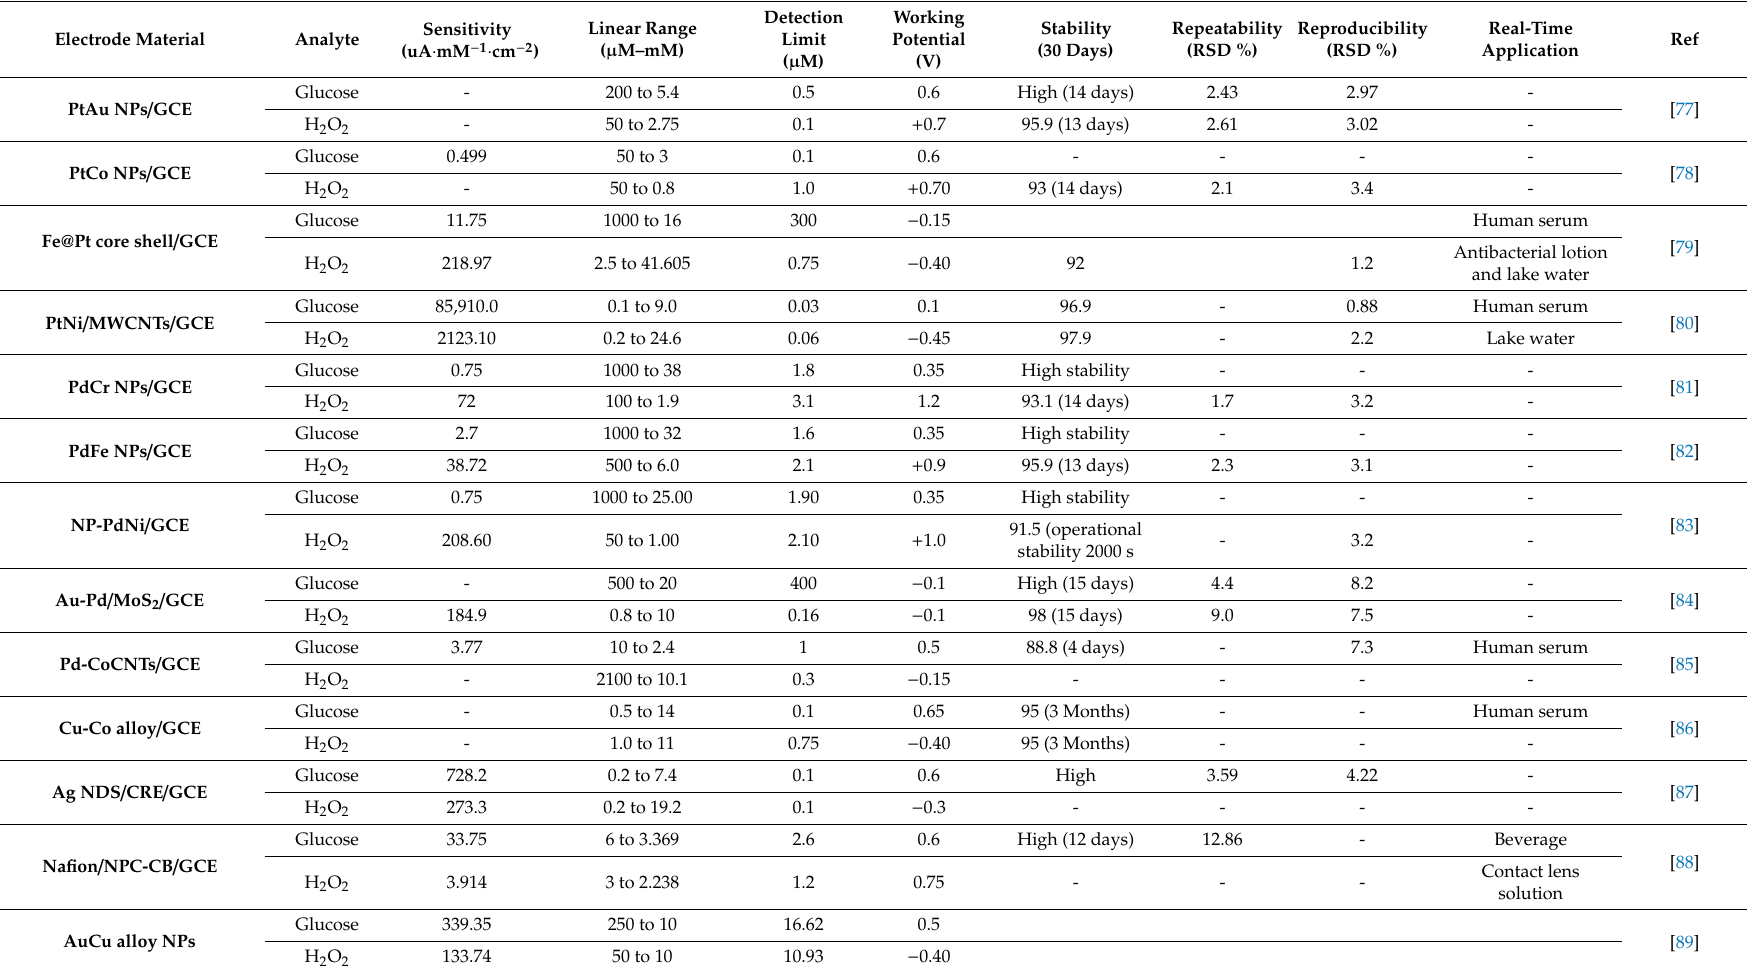
Table 3. Performance of non-enzymatic glucose and H 2 O 2 electrochemical sensors based on metal / metal